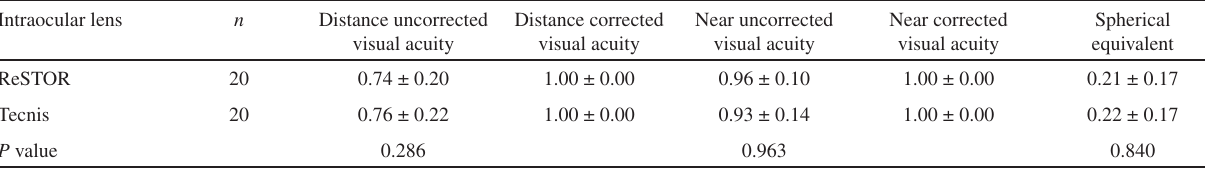
Table 1 - Visual performance of diffractive multifocal IOLs